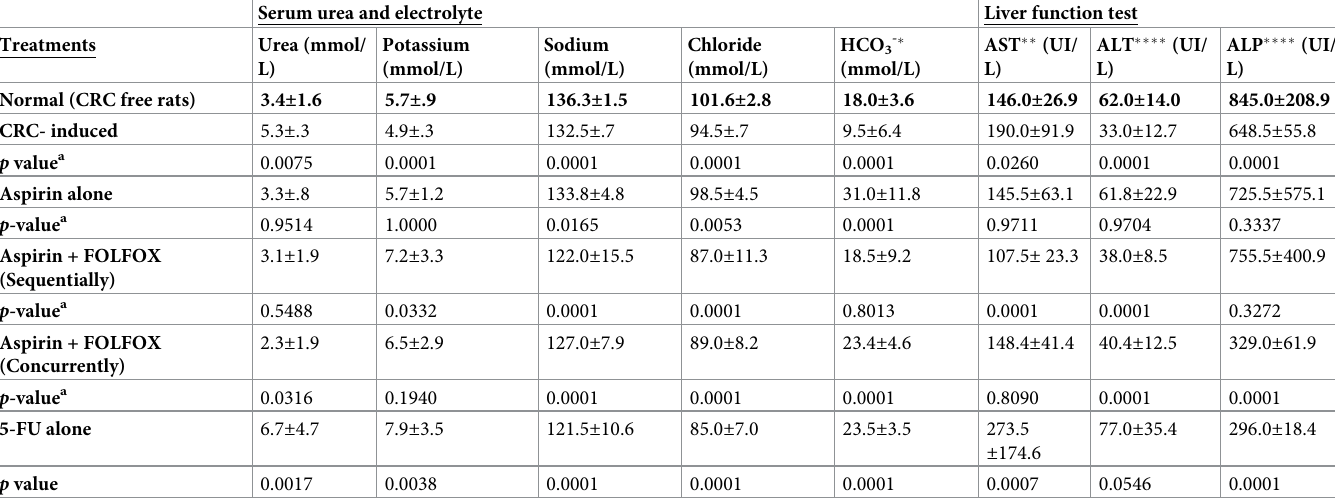
Table 5. Biochemical findings of various group of rats induced with colorectal cancer and treated with Aspirin plus FOLFOX chemotherapy in various combinations. Serum urea and electrolyte Liver function